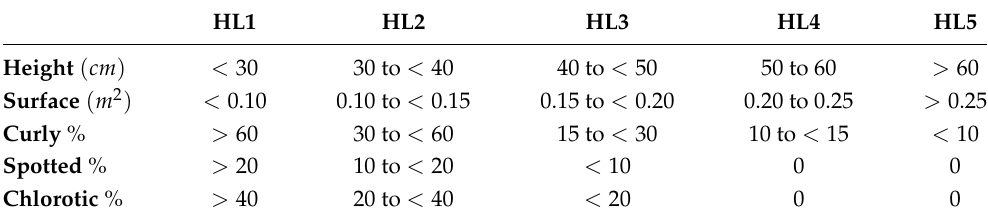
Table 2. Plant health categories based on phenotypic trait